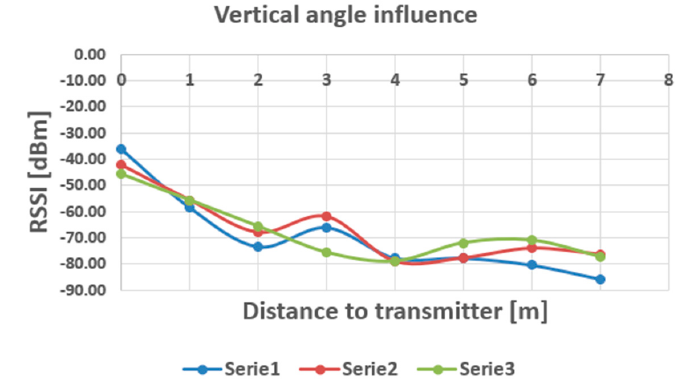
Figure 13. Influence of vertical position on the RSSI readings (Serie 1—V = 0 o , Serie 2—V = 45 o , Serie 3—V = 90 o ).